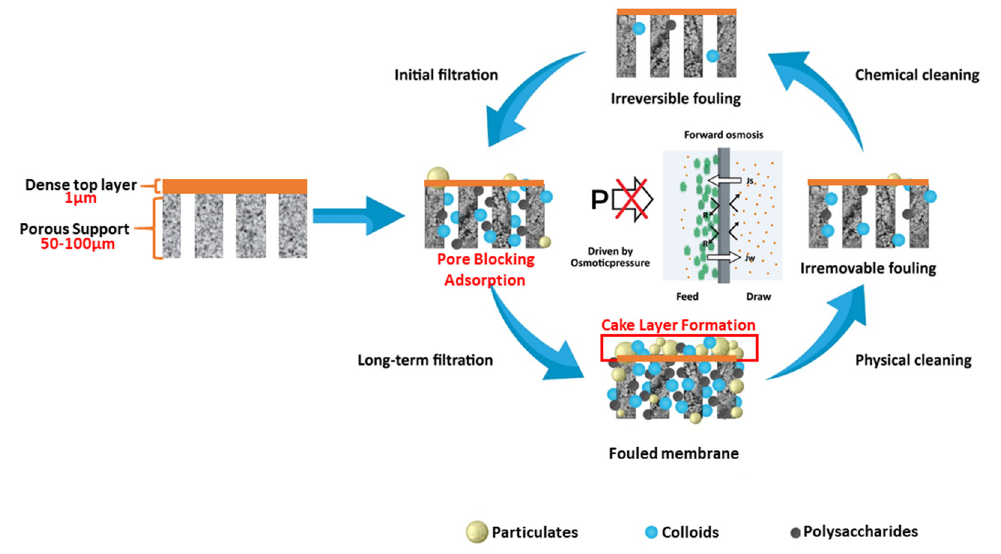
Figure 1. Schematic diagram of membrane fouling and cleaning mechanism in the forward osmosis (FO) processes.